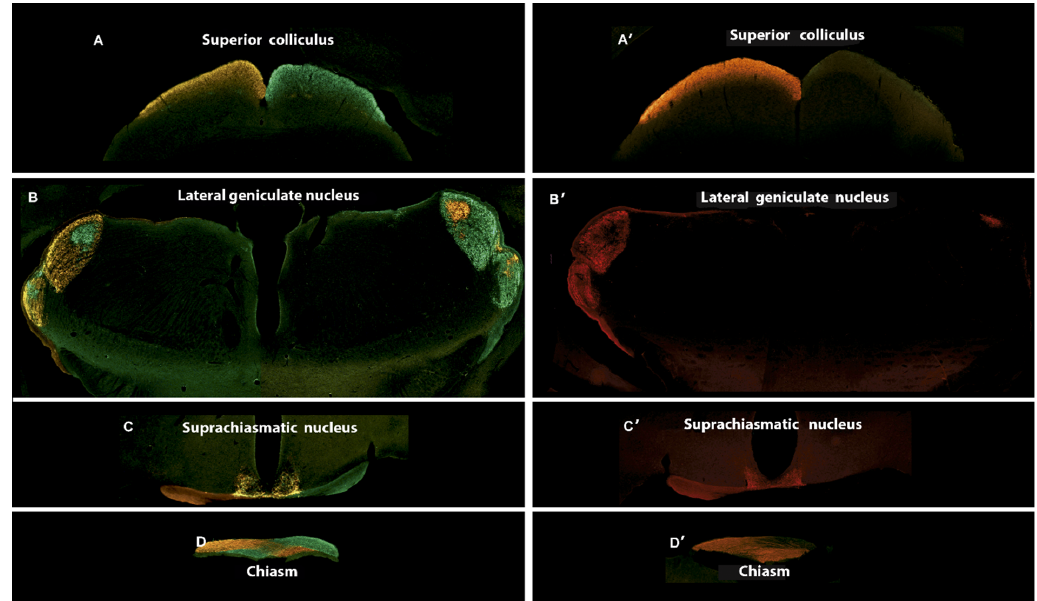
Figure 7. Central projections of retinal ganglion cells after intraocular injection of NMDA and Kainate. The Alexa Fluor® 488 and Alexa Fluor® 555 conjugates of the B subunit of the cholera toxin were injected intraocularly, into the left and right eyes, respectively, nine days after NMDA and Kainate injection. ( A – D ) Central projections in control animal. ( A’ – D’ ) Central projections in an experimental animal previously injected with 30 mM NMDA and 10 mM KA into the right eye ( A , A’ ) Section at the level of the superior colicullus ( − 3.52 mm from Bregma). ( B , B’ ) Section at the level of the